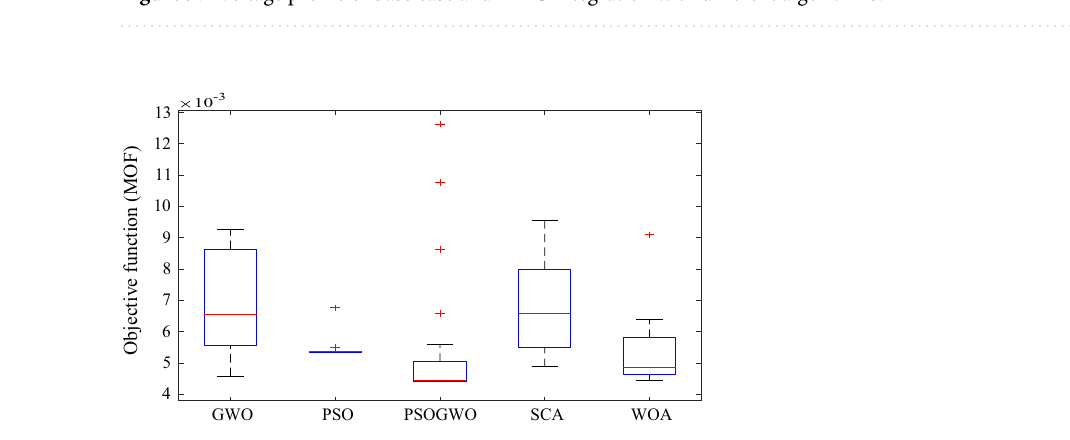
Figure 9. Voltage profile of base case and 2-DG integration with different algorithms.